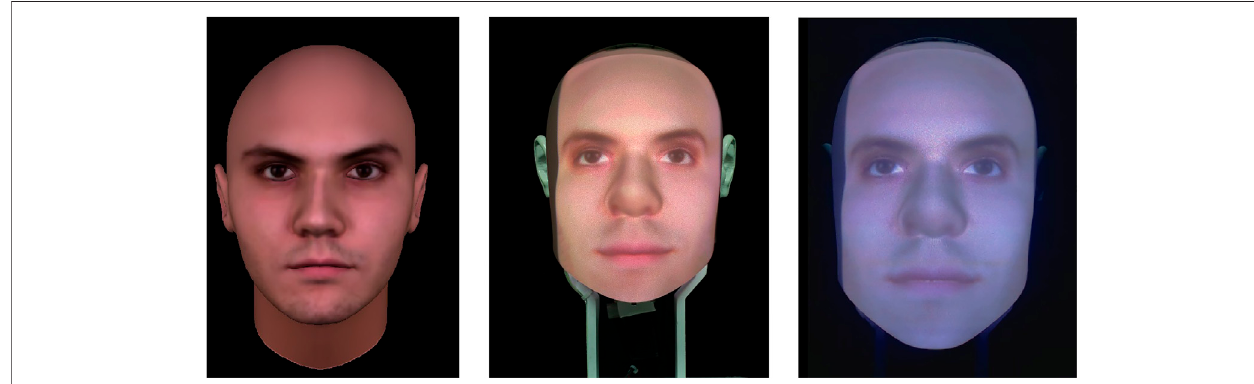
FIGURE 1 | Different types of arti fi cial embodiments used in the experiment. From left to right: a virtual agent; a physical Furhat robot; and a video recording of the Furhat robot.